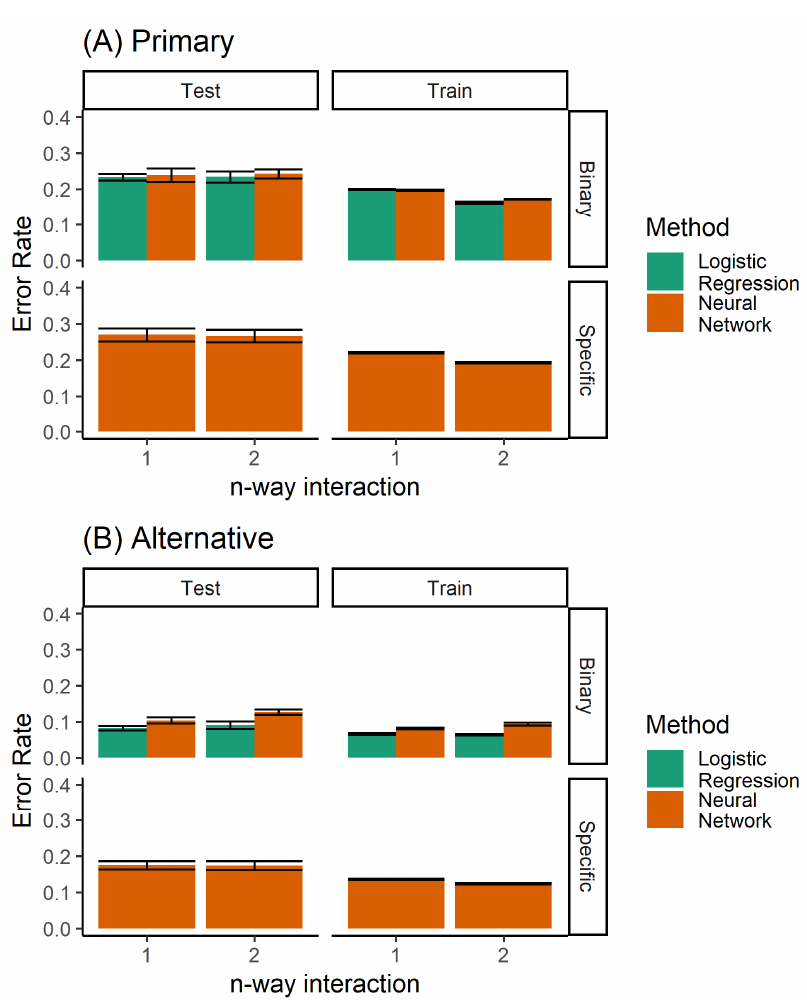
Figure 4. Performance of the single classifiers, when considering ( A ) only the primary diagnosis, and ( B ) both the primary and alternative.